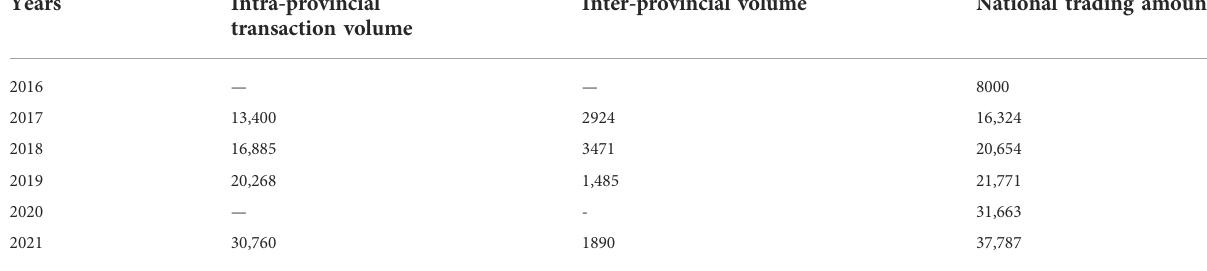
TABLE 1 China ’ s electricity trading volume in recent